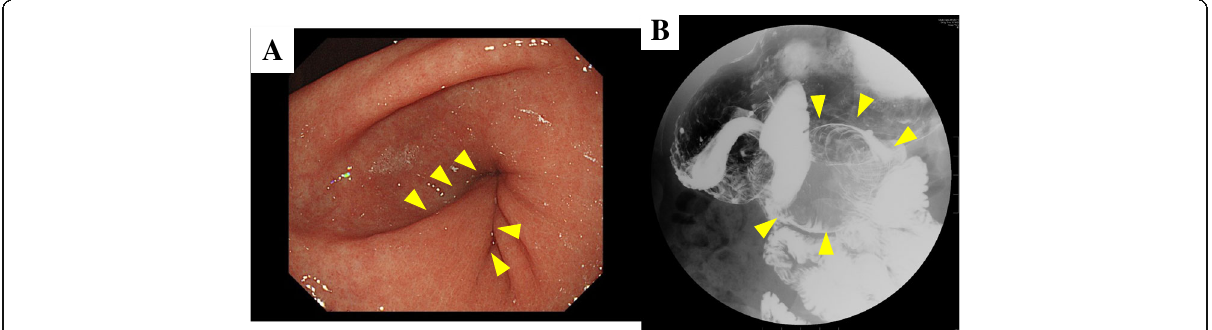
Fig. 3 Gastric fiber showed the pedunculated mass was originated from the stomach, which invaginated into the duodenum (arrow) ( a ). Gastric fluoroscopy showed the mass invaginated to the duodenum ( b